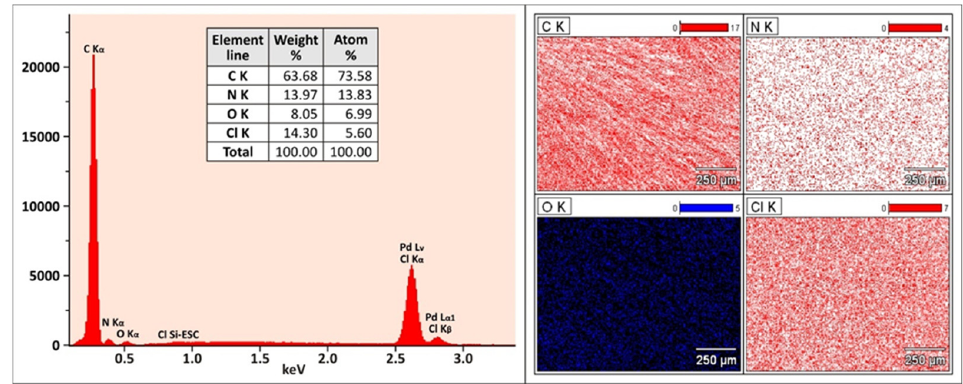
Figure 6. Structures of DES-3(1:3) sorbent confirmed by energy-dispersive X-ray